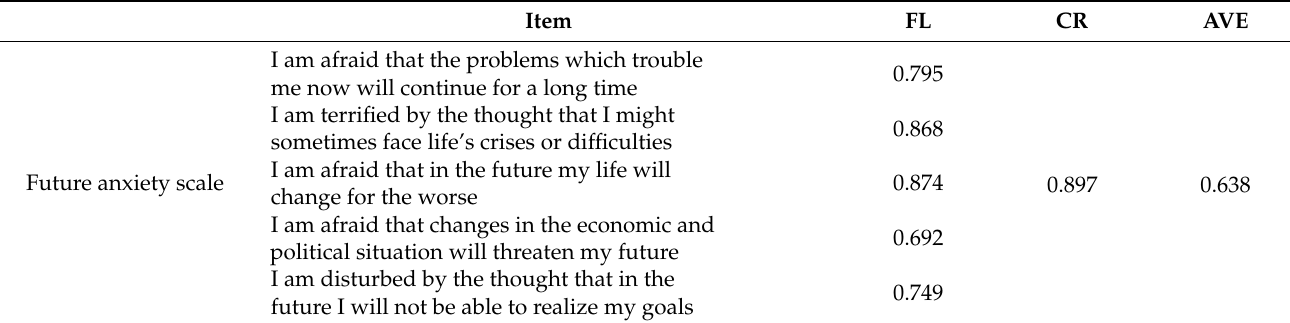
Table 3. Confirmatory factor analysis of the future anxiety scale.